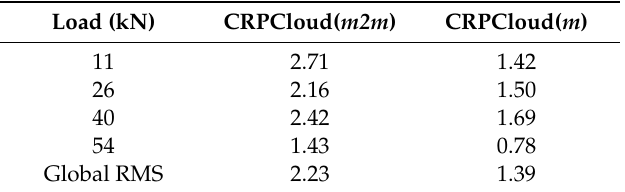
Table 15. RMS (mm) in the CRP-DPA comparison beam#1 Powershot LC1.